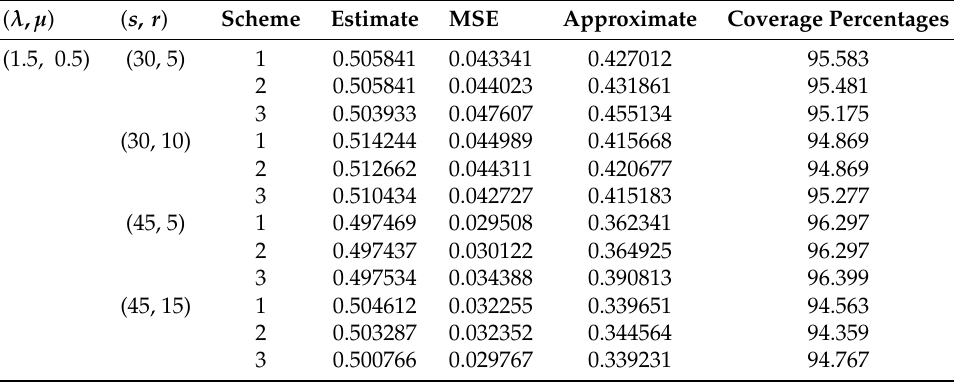
Table 8. Average values of estimate of µ with their respective MSEs, Average confidence interval and coverage